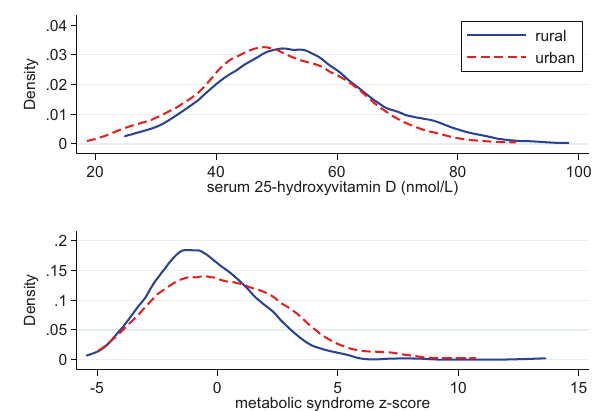
Fig. 1 Figure showing urban-rural right shift in the distribution of the metabolic syndrome score and urban-rural left shift in the distribution of serum 25(OH)D concentrations. Distribution of serum 25(OH)D concentrations and metabolic syndrome score by rural and urban residence (Cameroon study, n =